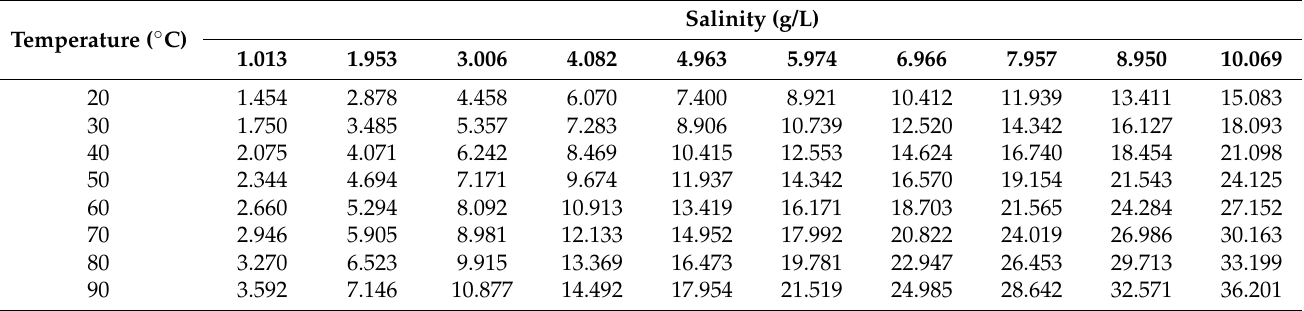
Table 3. Conductivity of solutions with different salinity conditions at different temperatures (unit: mS/cm). Temperature ( ◦ C)